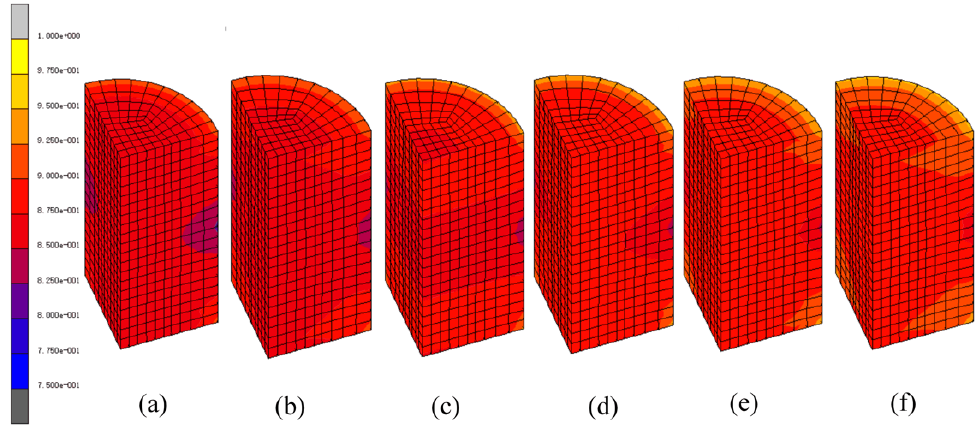
Figure 11. Relative density distributions in powder compacts at P = 200 MPa for Al contents of ( a ) 15 wt %, ( b ) 20 wt %, ( c ) 25 wt %, ( d ) 30 wt %, ( e ) 35 wt %, and ( f ) 40 wt %.